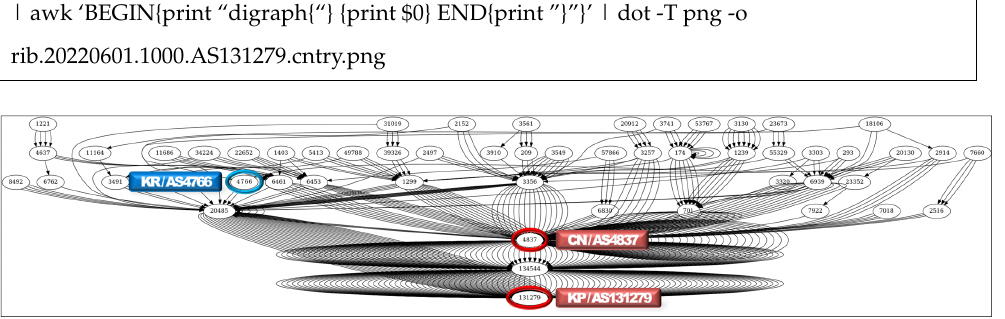
Figure 9. Di-graph visualization of BGP network topology between North Korea and China.